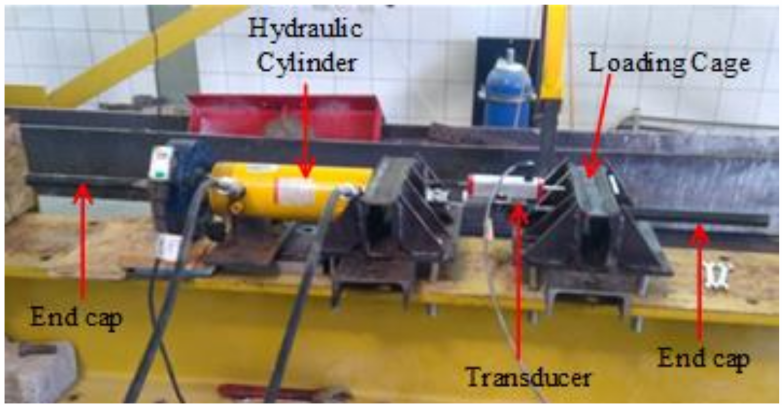
Figure 2. Setup for axial tension tests on FRP bar